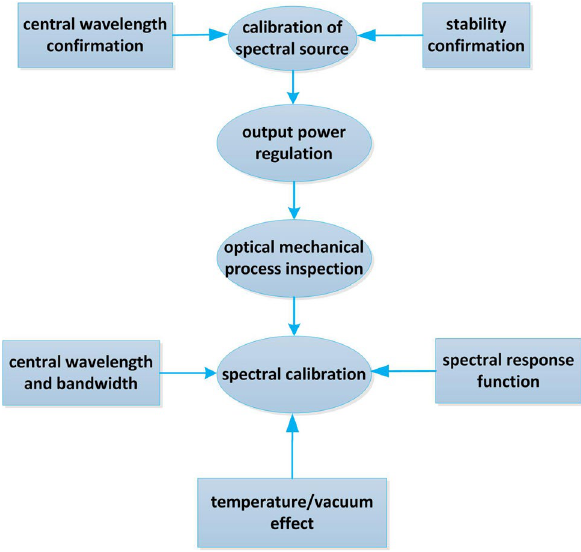
Figure 8. Flow chart of spectral calibration.